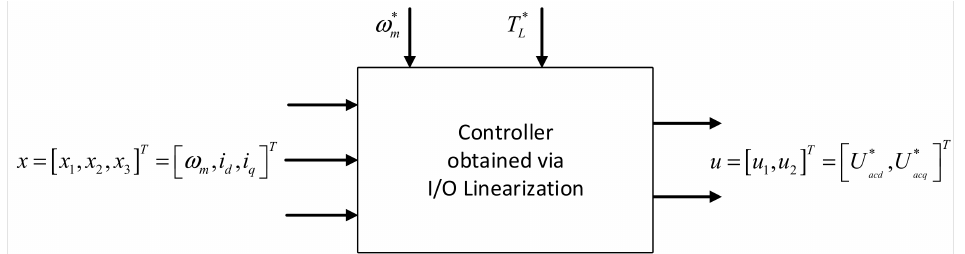
Figure 9. Block diagram of I/O linearized system with energy optimization ( Q ac ).